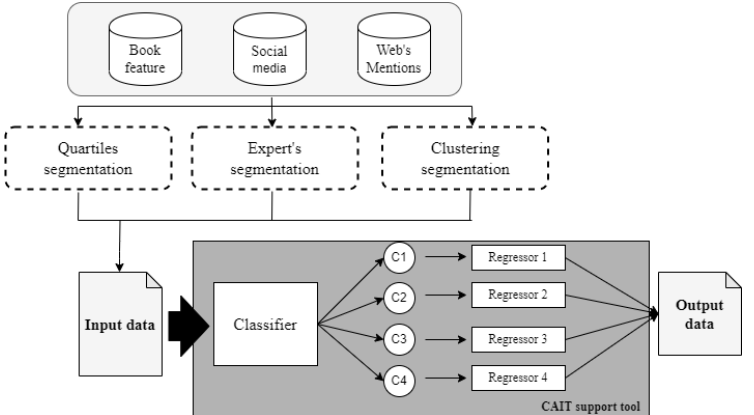
Figure 2. Research structure diagram. The input data in the combined model of Artificial Intelligence techniques (CAIT) support tool are tested with the three different segmentations. Upon entering into the system, they will be classified into the defined segmentations, and individual regressors will be applied for each segmentation. Finally, an output report is generated with the predicted data. The 4 classifications represented within CAIT are given: (1) the quartiles are influenced from the perspective of the experts; (2) by the expert ´ s segmentation there are 4; and (3) in the case of clustering segmentation, there could be more, but coincidentally the k groups gives a value of 4, as seen in the Section